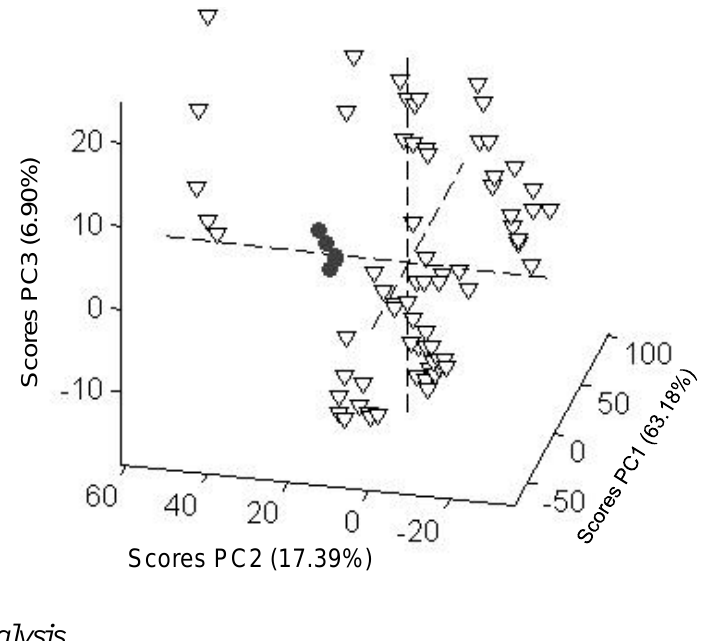
Figure 4. 3 PCA score plot of NH all the